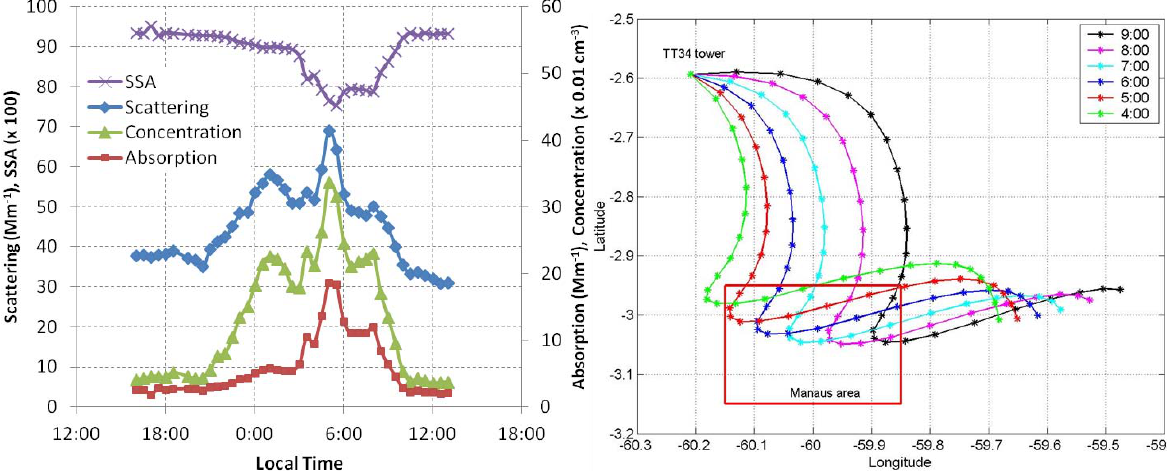
Fig. 14. Example of Manaus urban plume entrance in the research site on 25 April 2009. (a) Evolution of particle single scattering albedo – SSA (637nm), scattering coefficient (550nm), absorption coefficient (637nm) and number concentration; (b) HYSPLIT back-trajectories reaching the measurement site at the time specified (local time). Each trajectory point represents one hour less from the start